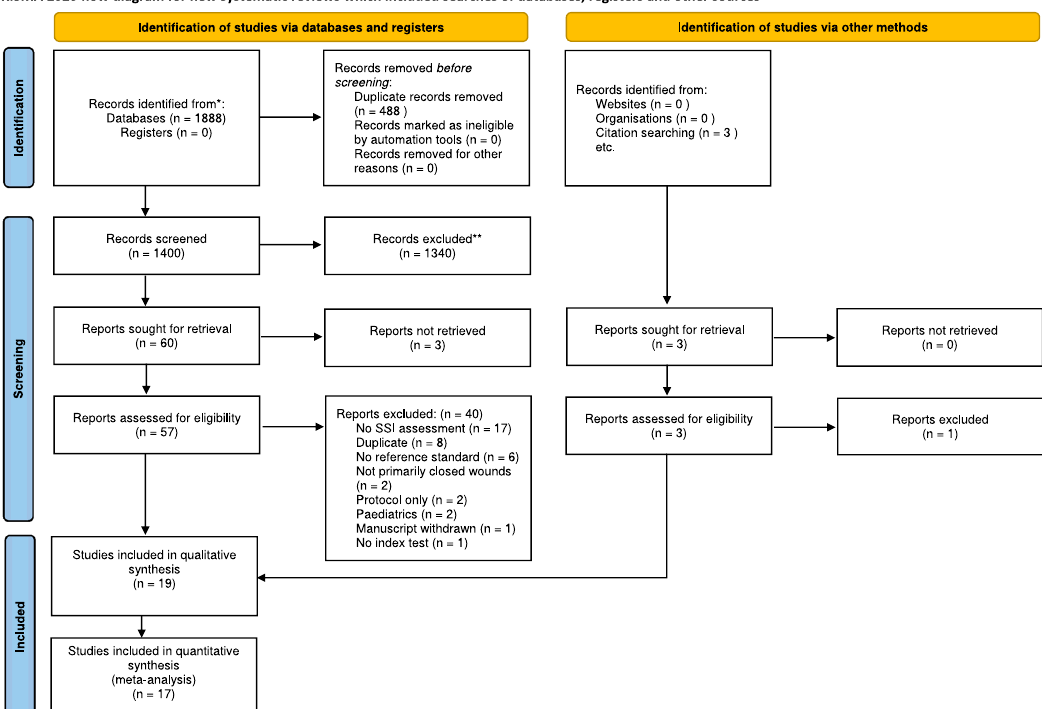
Fig. 1 PRISMA fl ow diagram for study selection process. Identi fi cation of studies via databases and registers is found in the left column, and via other methods on the